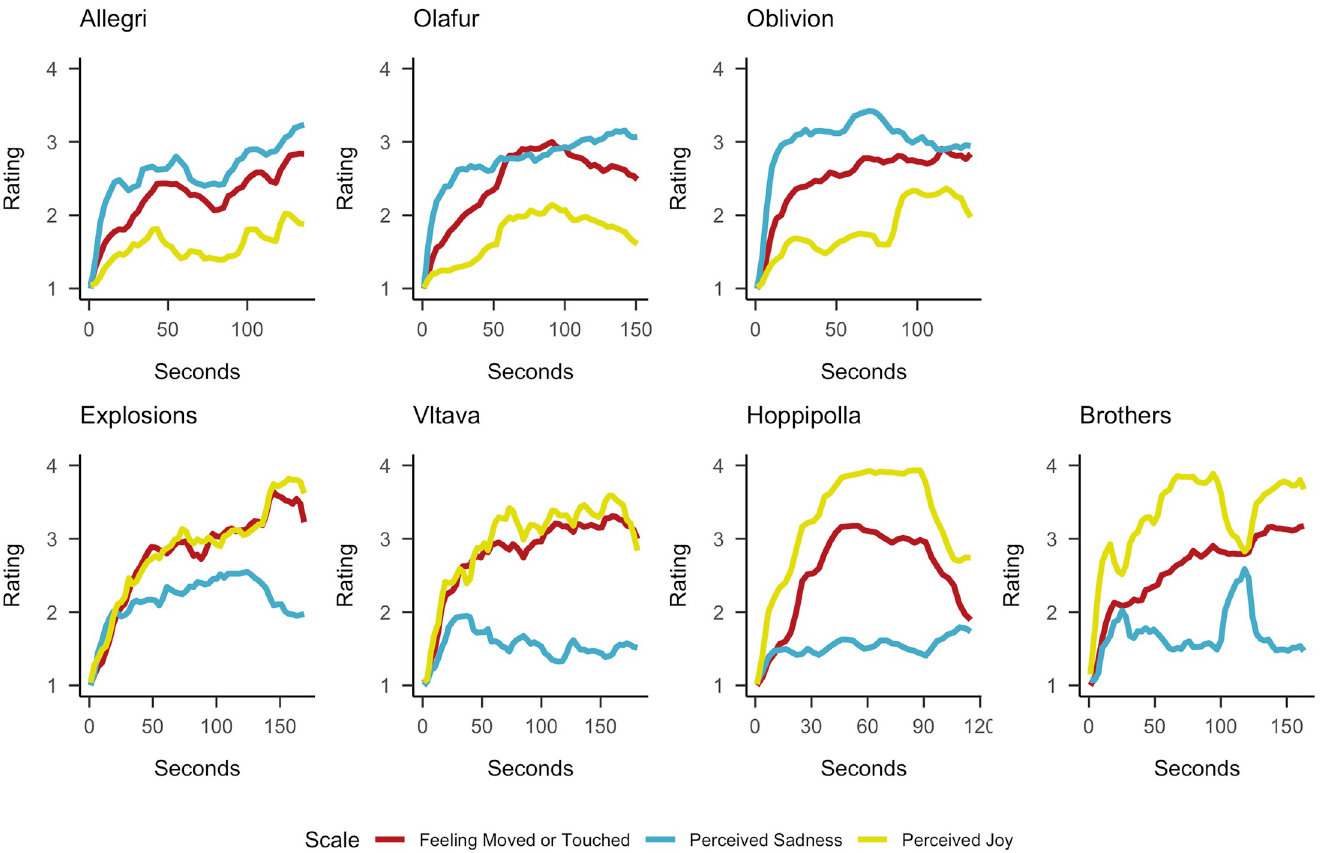
Fig 5. The averaged (non-detrended) continuous ratings of feeling moved or touched , perceived sadness , and perceived joy for the sadly (Upper Row) and joyfully moving (Lower Row) music excerpts. Ratings were provided on a 5-point scale (ranging from 1 (not at all) to 5 (extremely)) and aggregated in 3s time bins.